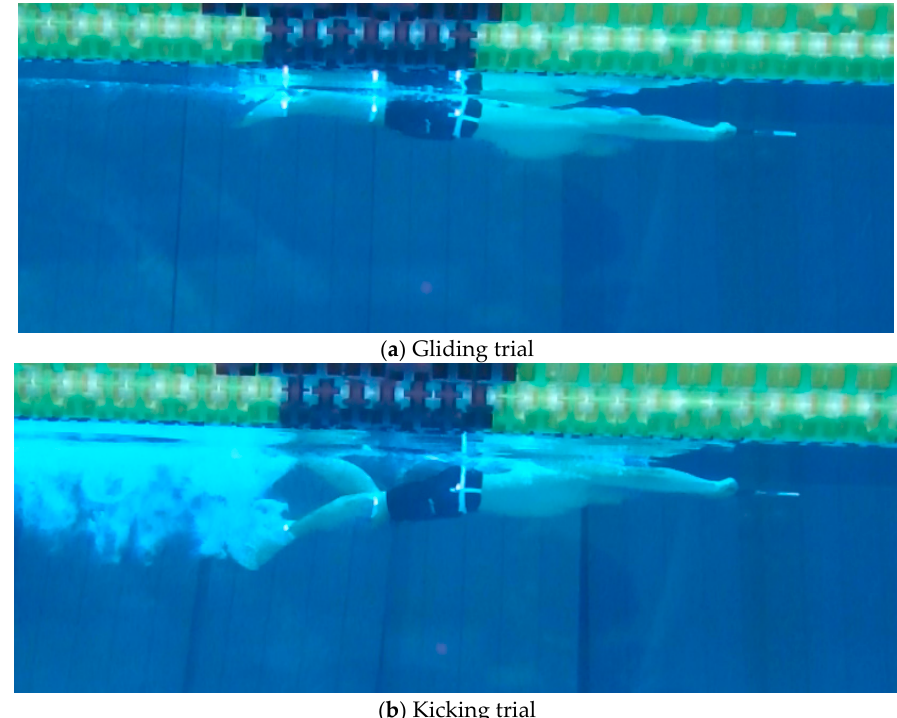
Figure 2. Photographs of a swimmer in the water surface condition. ( a ) Gliding trial; ( b ) Kicking